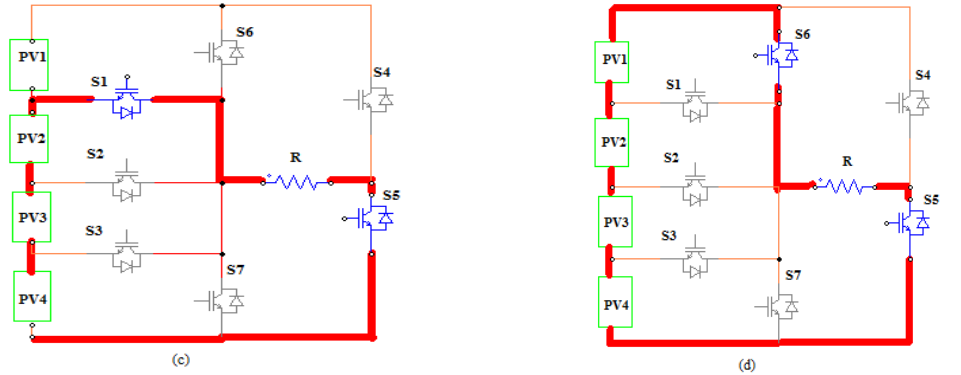
Figure 17. Positive sequences for synthesizing the nine-level output voltage. ( a ) output voltage = Vdc; ( b ) output voltage= 2 Vdc; ( c ) output voltage = 3 Vdc; ( d ) output voltage = 4 Vdc.